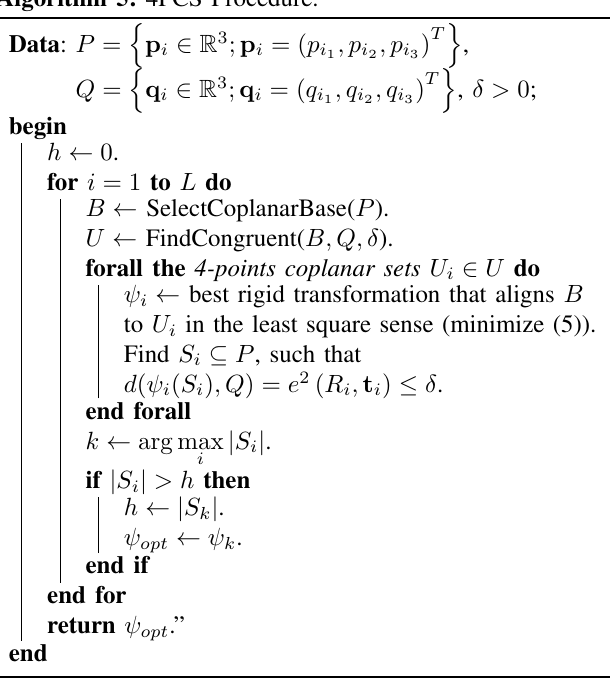
Algorithm 5: 4PCS